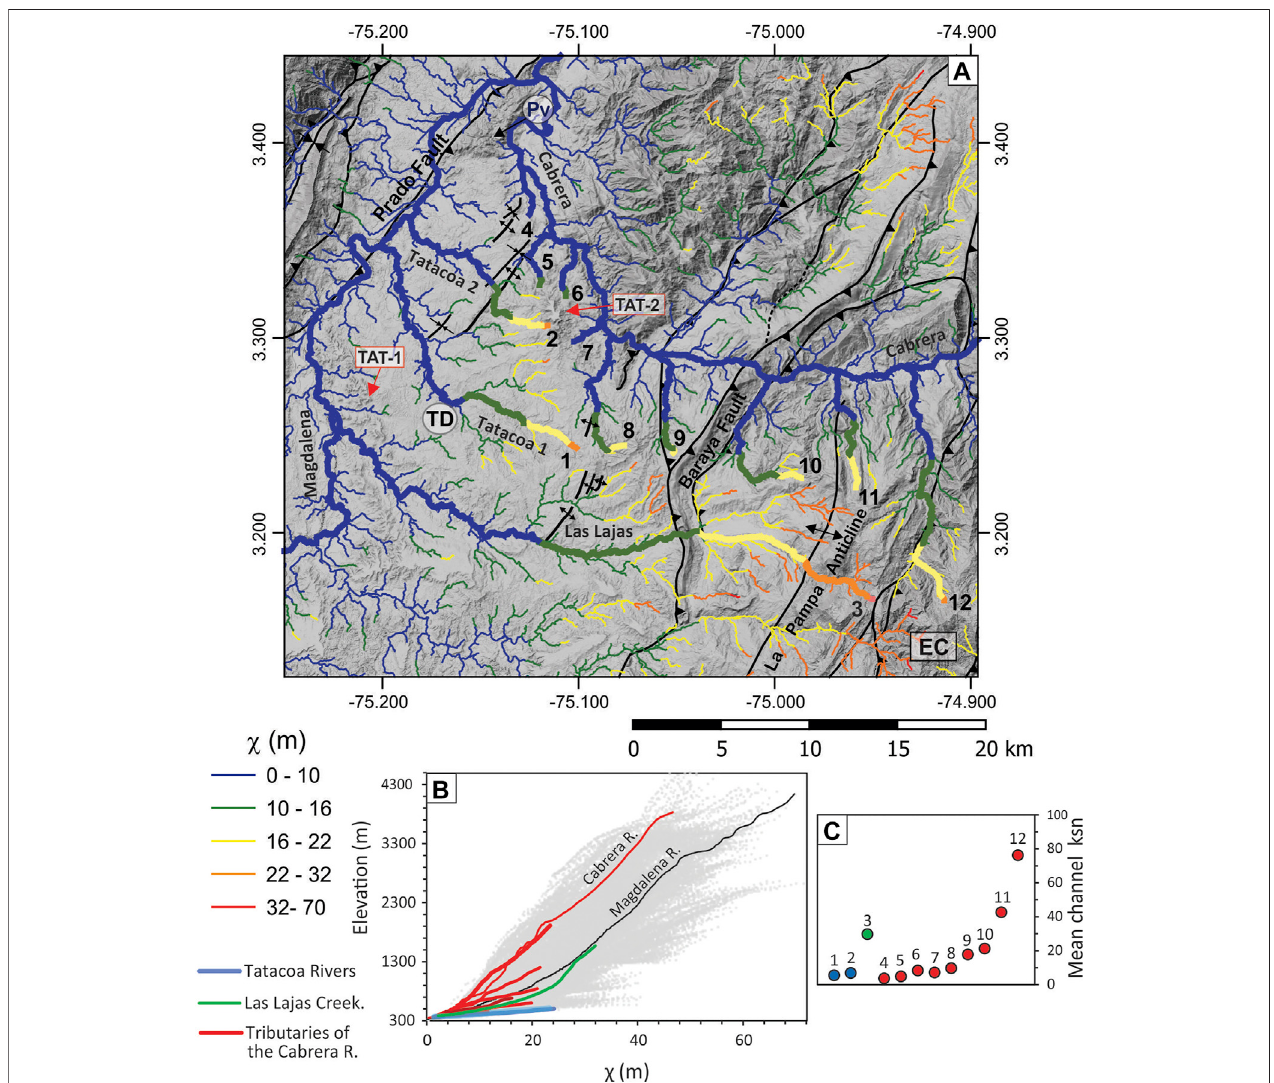
FIGURE 6 | (A) χ — map in a TanDEM-X derived composite hill shade and slope image. TD is the Tatacoa Desert; EC is the Eastern Cordillera; and Pv is the paleo valley; (B) χ -plotofUpperMagdalenacatchment,upstreamoftheMagdalena,andCabreracon fl uence.Graylinescorrespondtochannelsfromtheentirebasindataand colored lines are the thick channels highlighted in (A) ; and (C) ksn values of the highlighted channels in (B) , the numbers correspond to the channels shown in (A) .